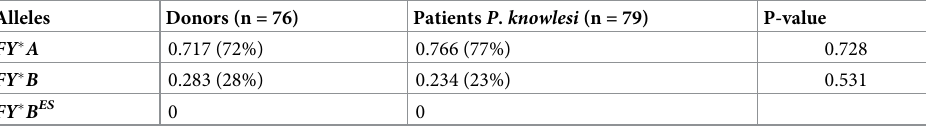
Table 3. Comparison of allelic frequencies between blood donors and P . knowlesi infected patients. Alleles